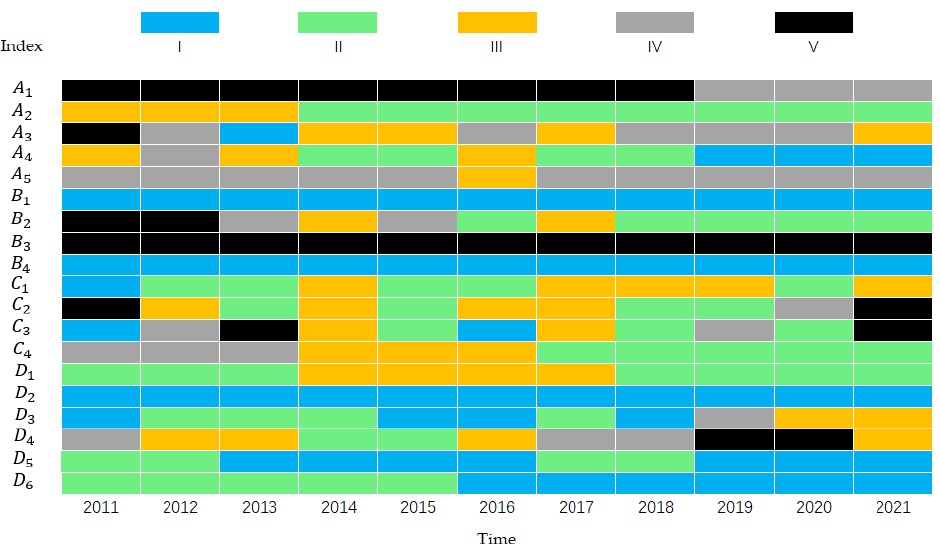
Figure 6. Health states of the evaluation indices in 2011–2021.